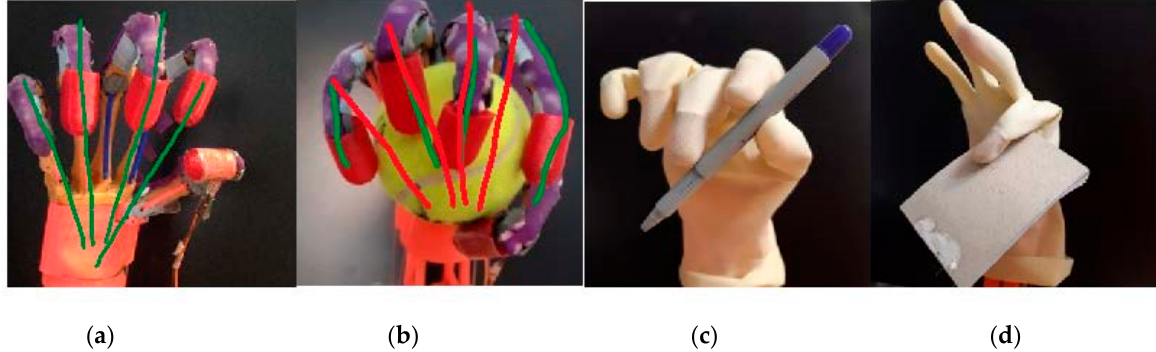
Figure 9. Prosthetic hand manipulation. ( a ) Grasping trajectory represented with green color, ( b ) grasp of a tennis ball without glove, ( c ) pencil grasp and ( d ) notebook grasp.